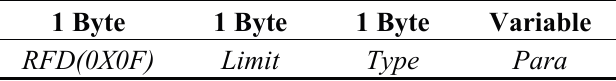
Table 2. Frame format on sensor